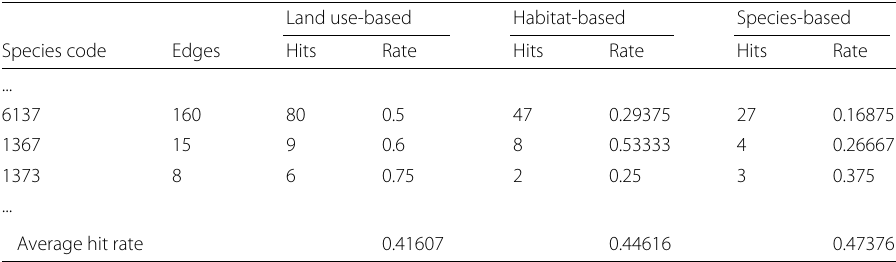
Table 3 Excerpt of the table of hit rates Land use-based Habitat-based